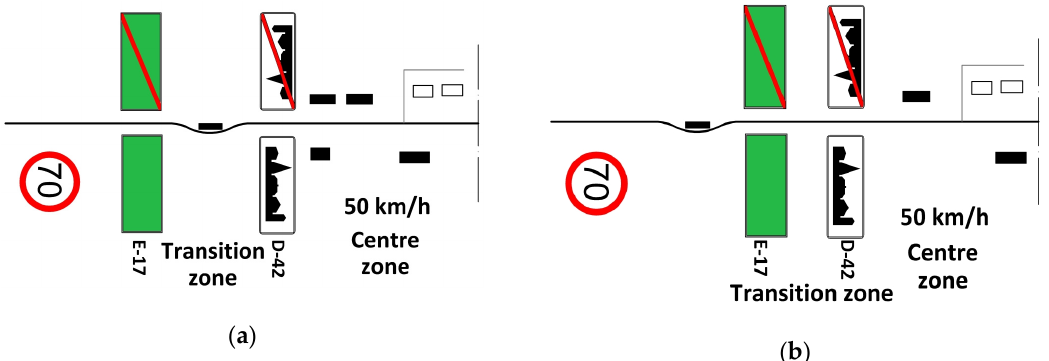
Figure 3. Example layout of the E-17 and D-42 traffic signs: ( a ) on sections where a considerable speed reduction was recorded; ( b ) on the remaining test sections.